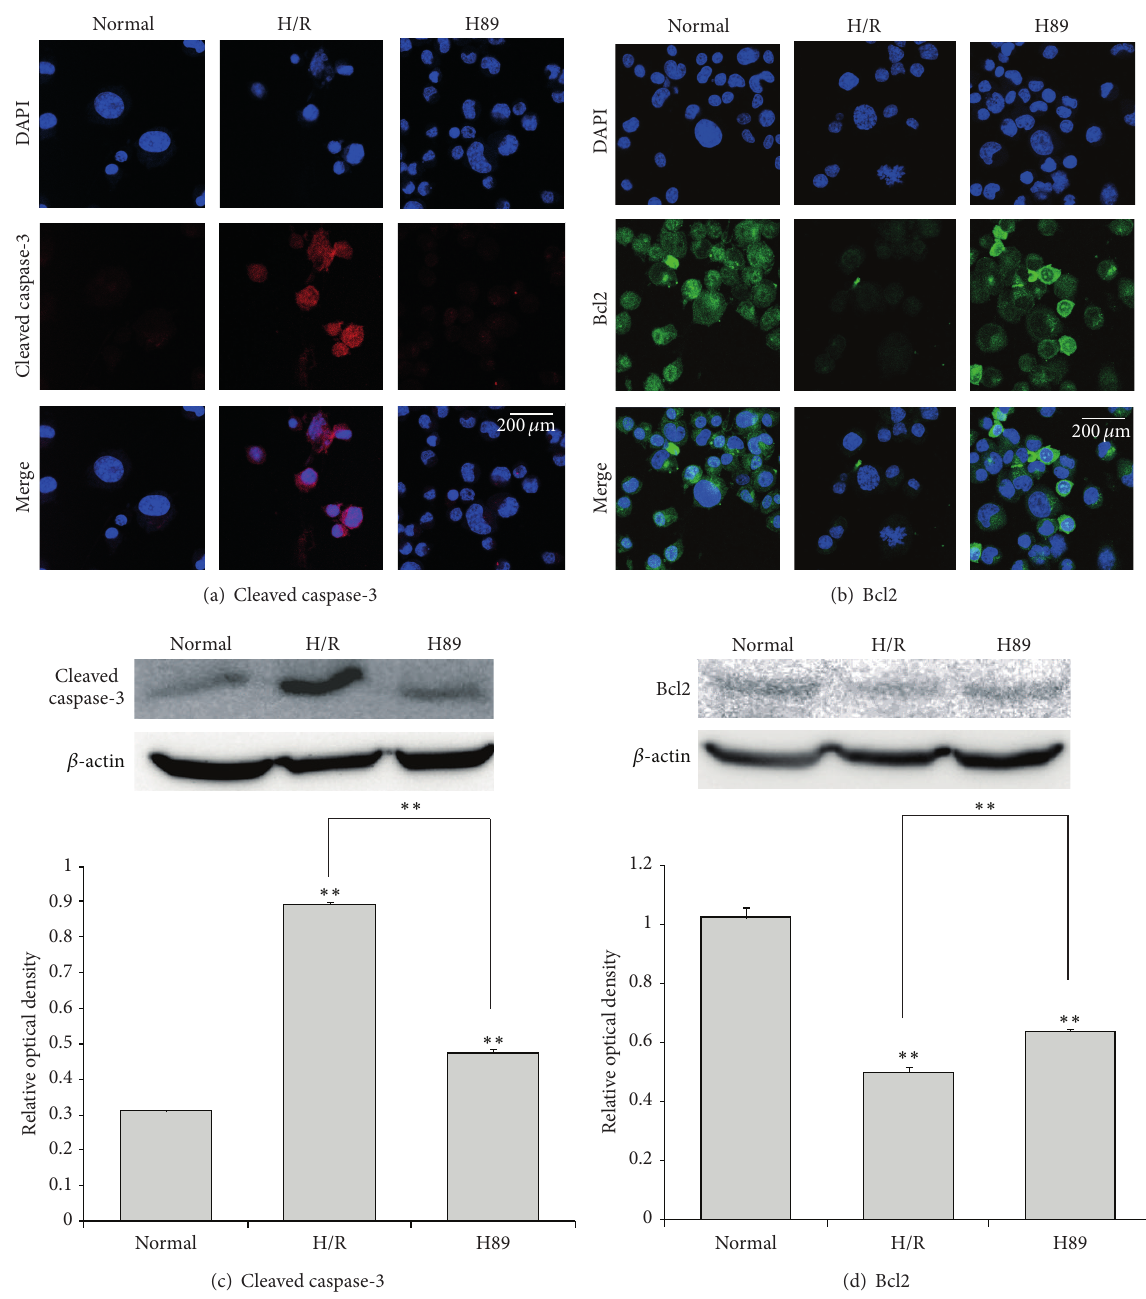
Figure 5: The measurement of cleaved caspase-3 and Bcl2 expression in Neuro2A cells after H/R-induced injury. (a) The level of cleaved caspase-3 was evaluated by immunocytochemistry. This image shows that the expression of cleaved caspase-3 in the H/R group was strongly increased compared to the normal group. Cleaved caspase-3 expression was attenuated in H89 pretreatment treatment group under H/R- induced injury. (b) The level of Bcl2 was evaluated by immunocytochemistry. This image shows that the expression of Bcl2 in the H/R group wasincreasedcomparedtothenormalgroup.PKAinhibitorH89pretreatmentpreservedtheexpressionofBcl2inspiteofhypoxiareperfusion injury. (c) Western blotting experiments showed that the relative protein expression of cleaved caspase-3 evidently attenuated in the H89 group compared to the hypoxia reperfusion group. (d) Western blotting experiments showed that the relative protein expression of Bcl2 slightly increased in the H89 group compared to the hypoxia reperfusion group. Data were expressed as mean ± S.E.M, and each experiment included 4 repeats per condition. Differences were considered significant ∗∗ 𝑃 < 0.001 . Scale bar: 200 𝜇 m, cleaved caspase-3: red, Bcl2: green, 4 󸀠 ,6-diamidino-2-phenylindole (DAPI): blue, normal: the normal control group, H/R: 4 hr hypoxia and 18 hr reperfusion injury group, and H89: 2 hr PKA inhibitor H89 treatment group before 4hr hypoxia and 18hr reperfusion